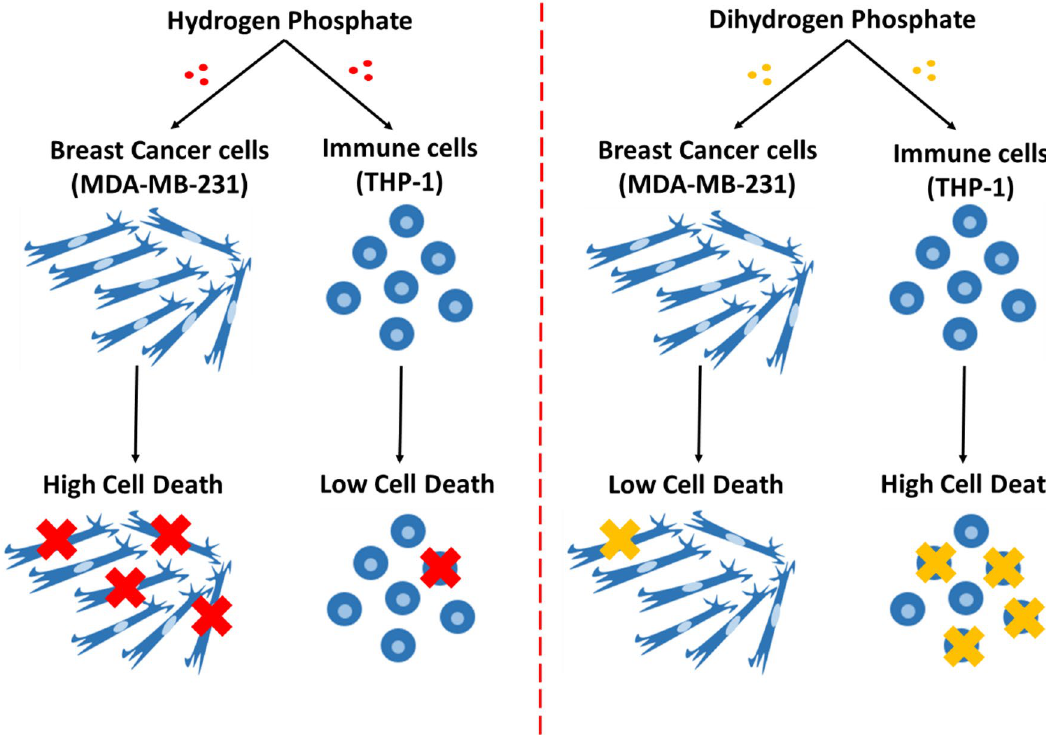
Figure 9. Schematic diagram—effect of hydrogen phosphate vs. dihydrogen phosphate on the cell viability of MDA-MB-231 and THP-1 cells. Hydrogen phosphate causes significant death in MDA-MB-231 cells but not in THP-1 cells, unlike dihydrogen